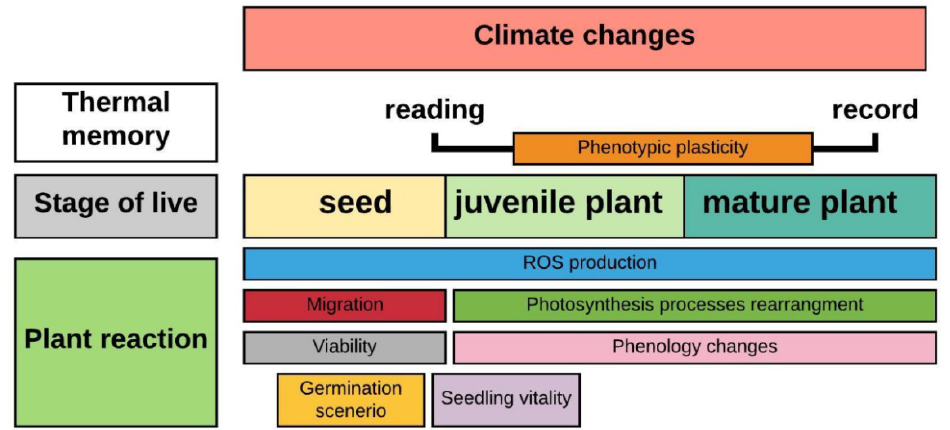
Figure 1. Rapid changes in climate conditions influence each of stage of a plant’s life, from seed production by juvenile and mature plants. Thermal memory recorded due to phenotypic plasticity in mature organisms is passed on to the seed, in which the thermal memory is read. As a consequence of climate changes, reactive oxygen species ROS production may change at each of stage of life; important di ff erences in the proper functioning of photosynthesis also occur. Acceleration or delay of developmental programs is observed as a change in the phenology of the species. Changes in the climate may interfere with the viability of seeds and may cause modifications in germination scenarios or seedling vitality. Seeds are plant organs that may, as a consequence of these events, migrate to establish new territory and change the range of populations and even species.